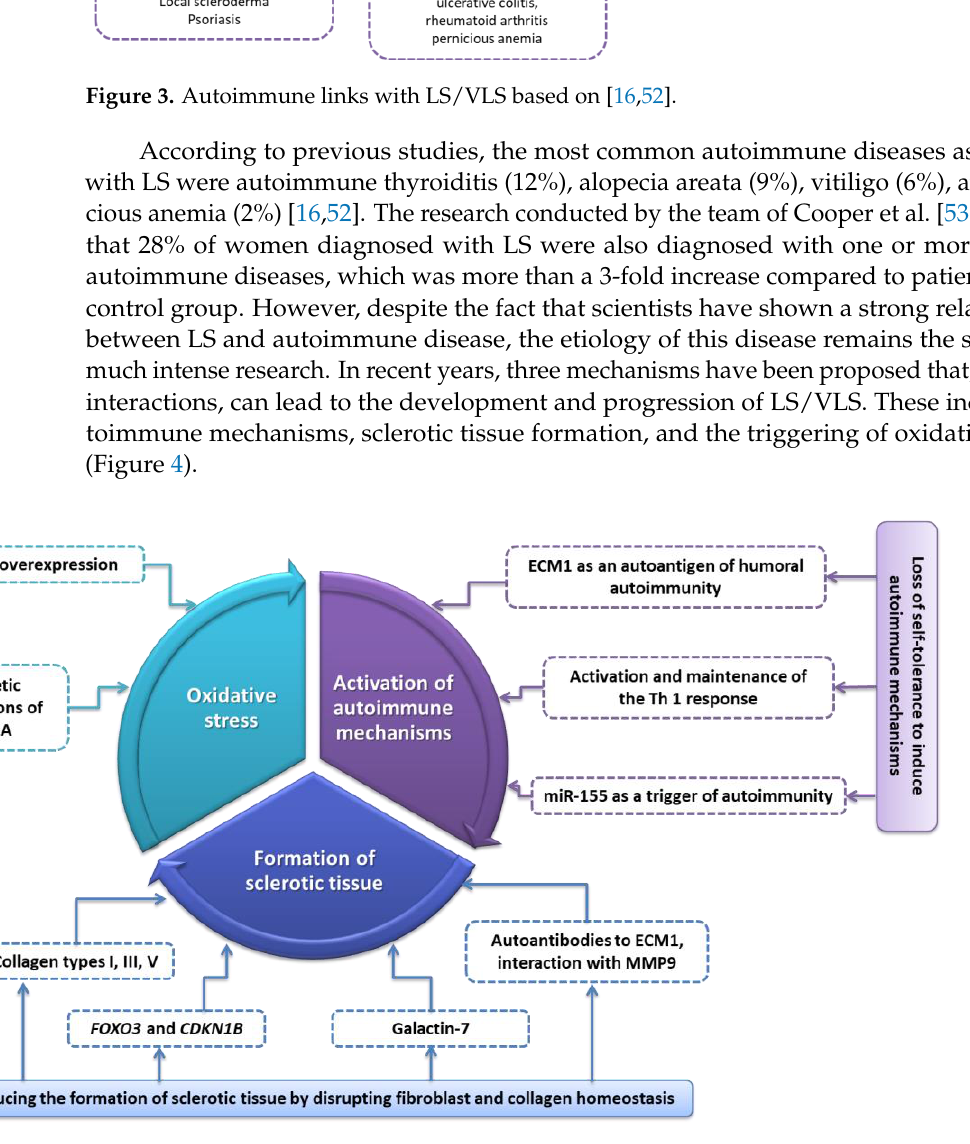
Figure 4. Schematic representation of the three major mechanisms involved in LS/VLS pathogenesis based on [14]. ECM1 — extracellular matrix protein 1; CDKN1B — cyclin-dependent kinase inhibitor based on [14]. ECM1—extracellular matrix protein 1; CDKN1B—cyclin-dependent kinase